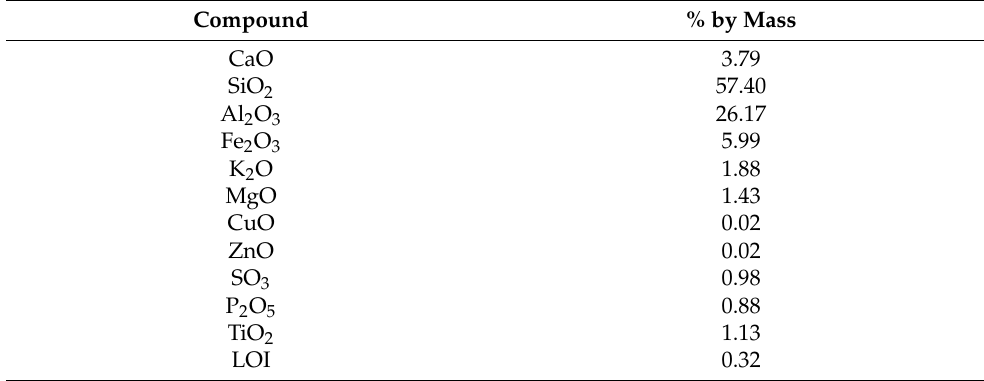
Table 1. Chemical Composition of Fly